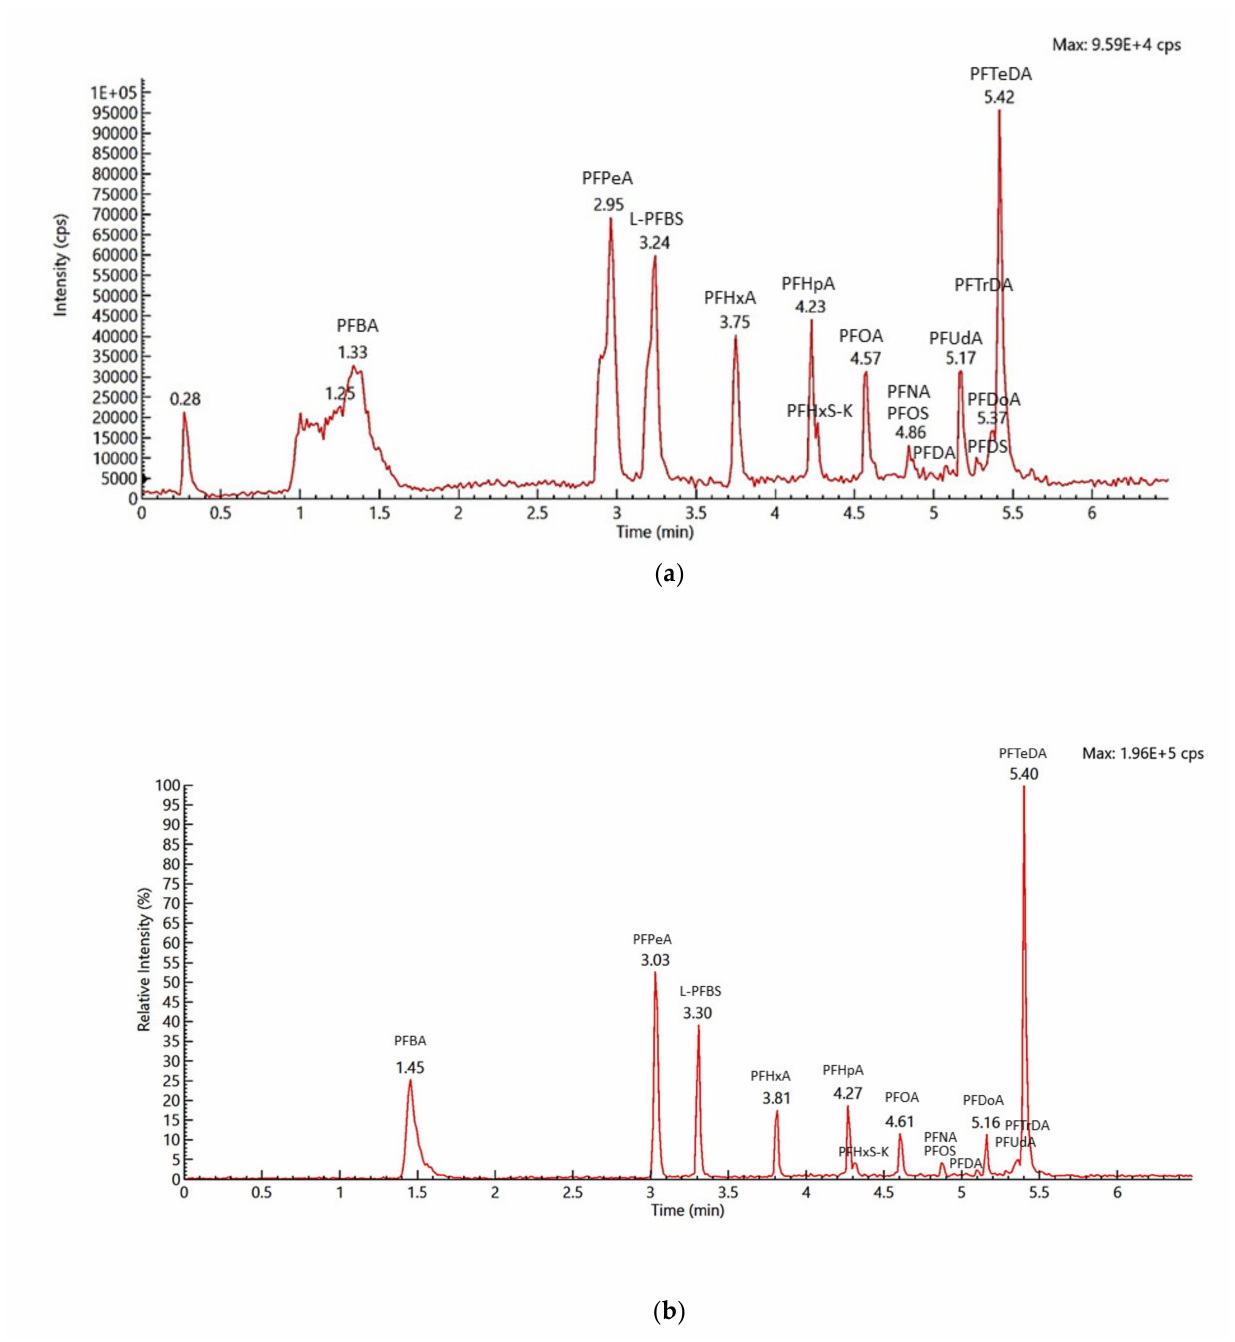
Figure 4. ( a ) Total ion chromatogram of 10,000 ng kg − 1 PFAS spiked in milk in MRM acquisition mode. ( b ) Improved total ion chromatogram of 10,000 ng kg − 1 PFAS spiked in milk in time-managed MRM acquisition